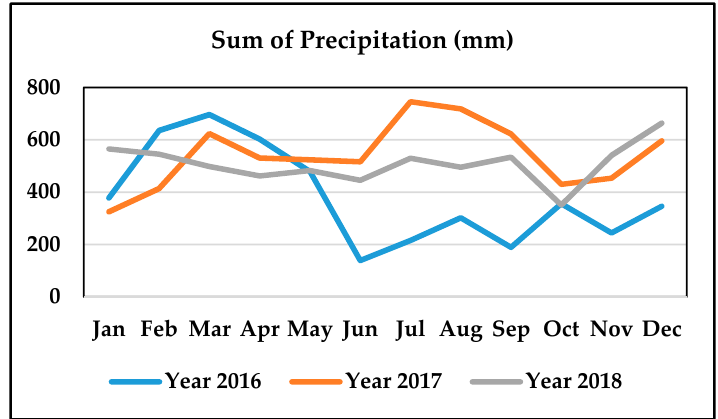
Figure 3. Sum of precipitation in the ore processing industry area in Indonesia.